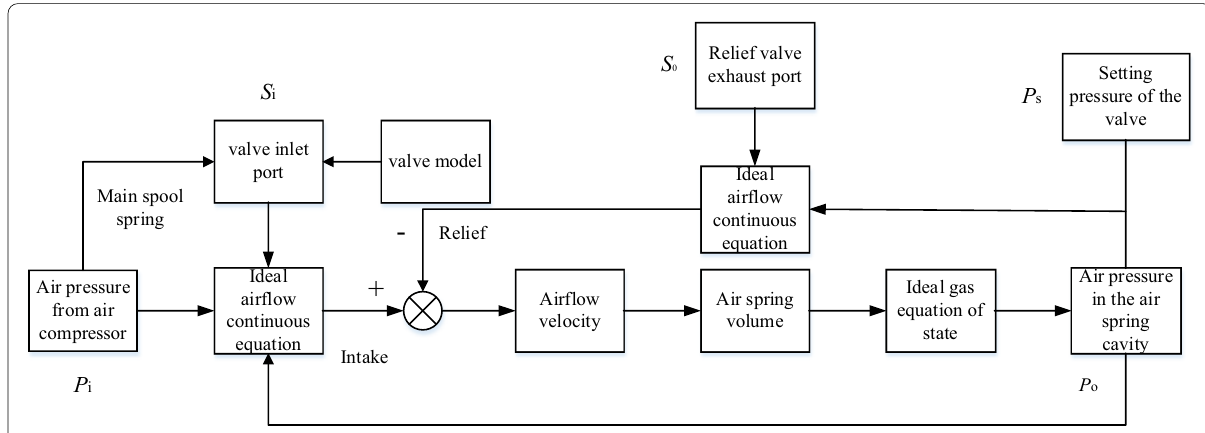
Figure 6 The dynamic analysis of vibration isolation system with pressure